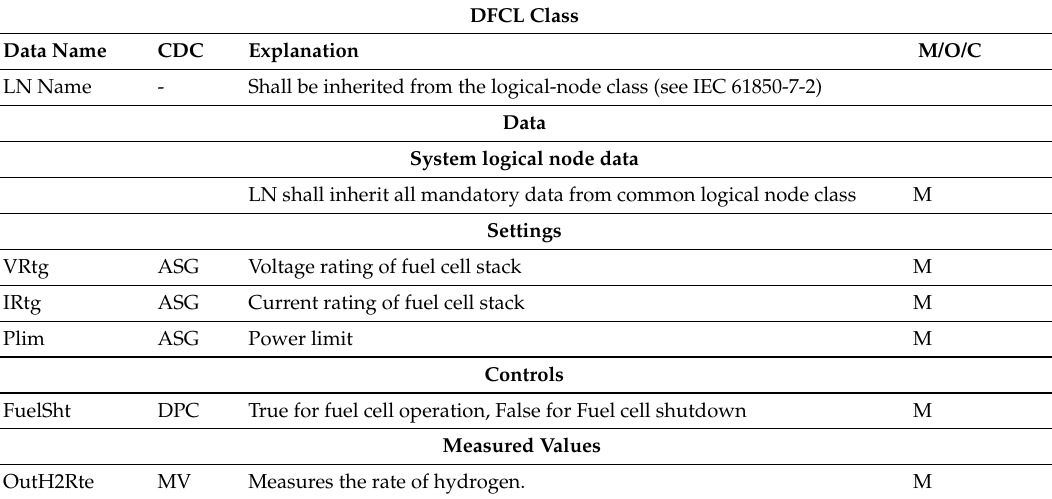
Table 5. Fuel cell controller (DFCL) logic node.